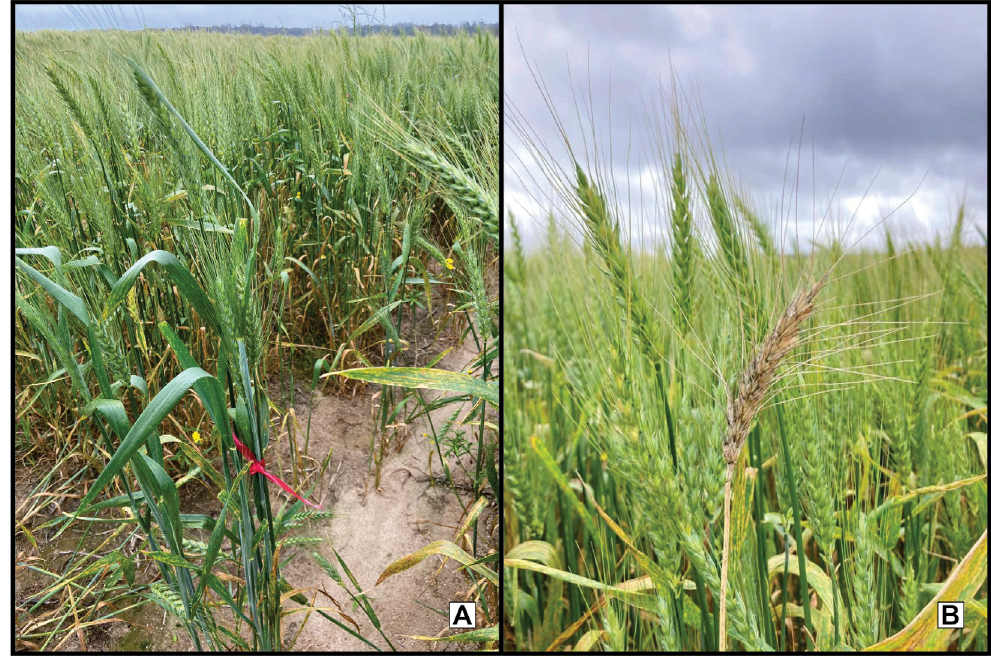
mutant plant showing resistant phenotype; B. M Figure 3 - A. M 4